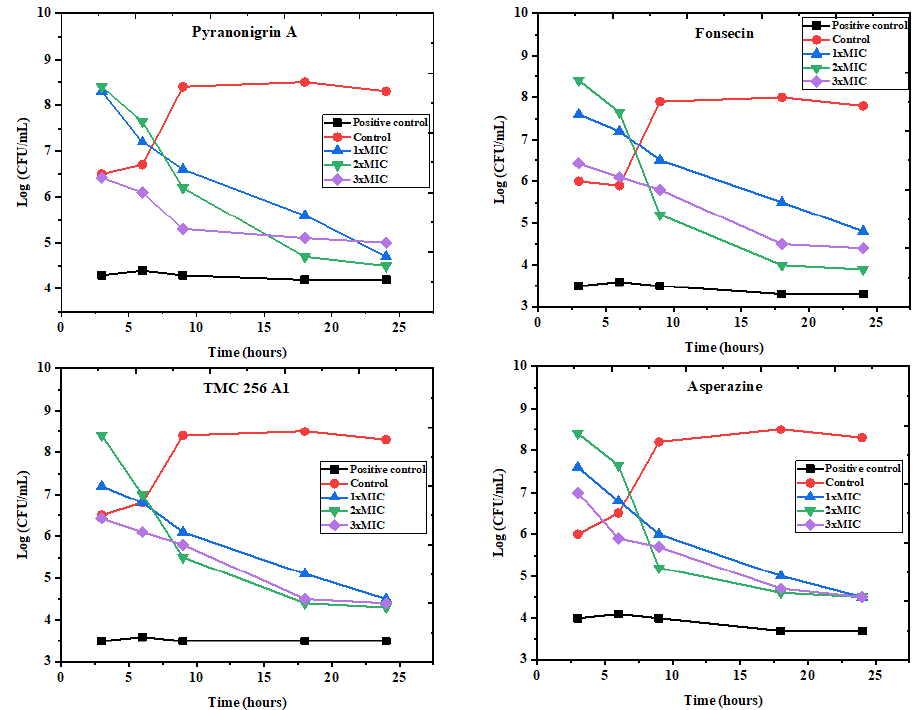
Figure 6. The time – kill kinetics of pure compounds ( 1 – 4 ) obtained from the active fraction of A. tubingensis (NA103) against P. aeruginosa. Red control indicates cells without treatment, while positive control indicates treated cells with 50 mg/mL of tetracycline.